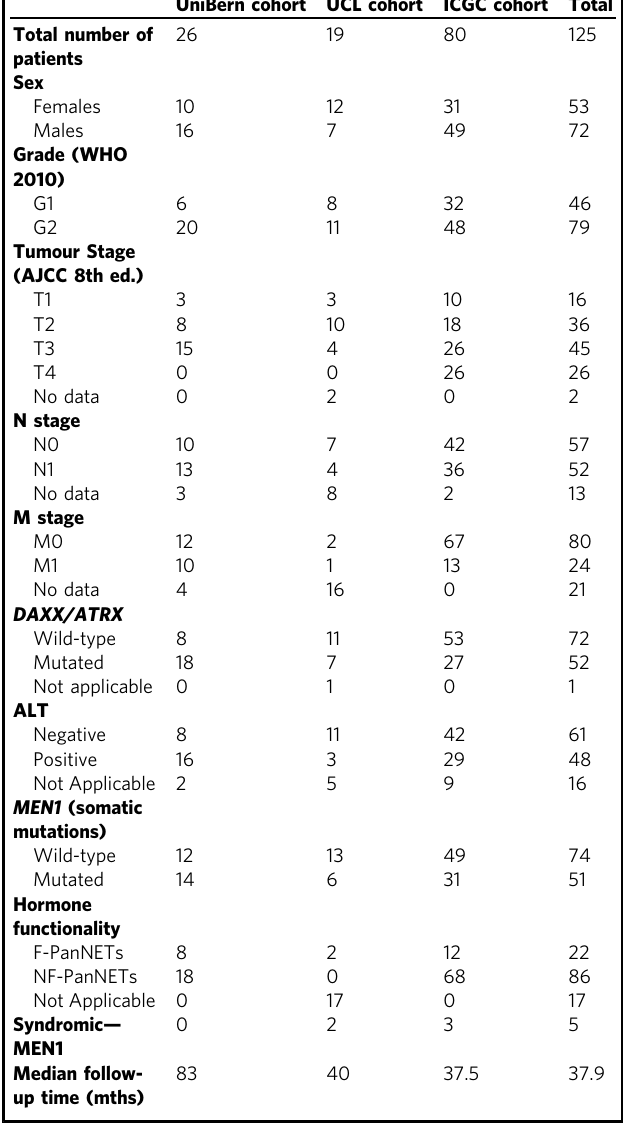
Table 1 Patient cohort used for methylome analysis (cohort